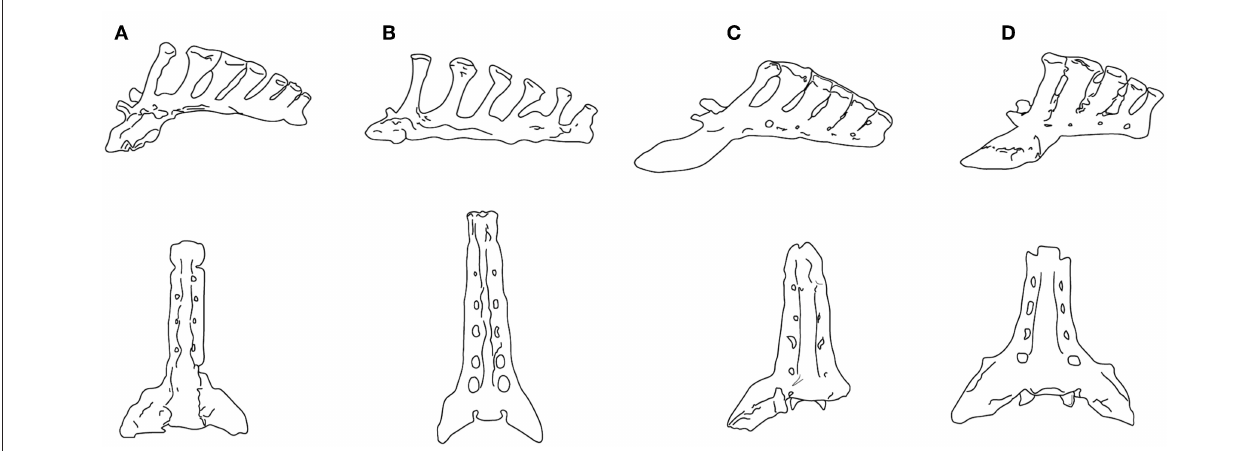
FIGURE 6 | Sacra in left lateral view (upper) and ventral view (lower). (A) Neohipparion coloradense (F:AM 69511); (B) Hippotherium primigenium , modified from Figure 5.4.2 in Bernor et al. (1997); (C) Pliohippus pernix (F:AM 60872); (D) Equus grevyi (AMNH 82036). (F:AM = Frick Collection, American Museum of Natural History). All specimens drawn to the same size, not to scale. Photographs taken by CMJ. Illustration by James G.